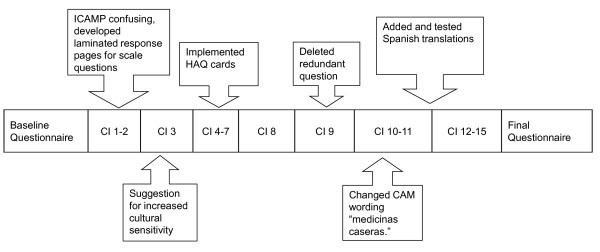
Iterative process.